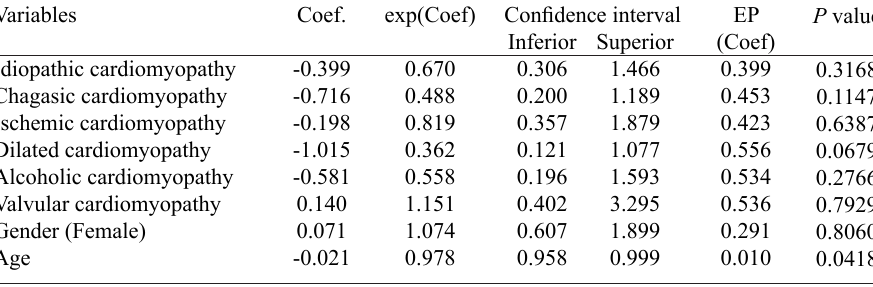
Table 3. Model from adjusted Cox proportional hazards survival data of patients undergoing heart transplantation. Fortaleza, Ceará, Brazil. 2011